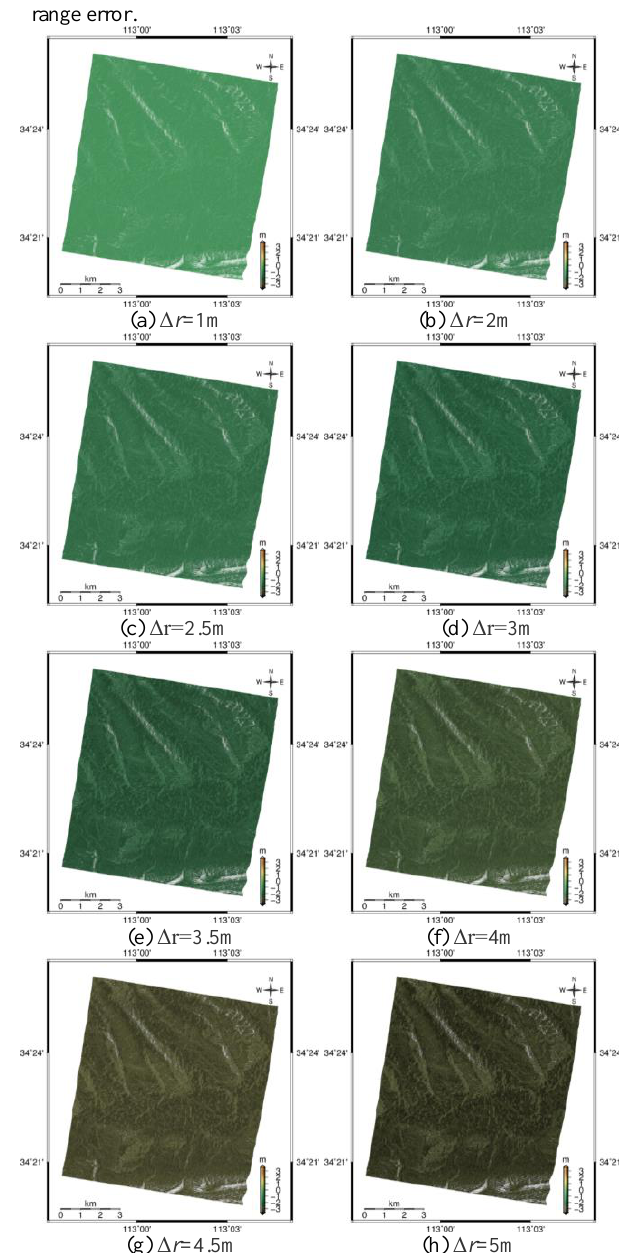
Figure 8. Height error distribution graph induced by different slant range error The simulation results indicate that the slant range error has obvious influence on the InSAR height measurement. With the increase of slant range error, the height measurement error raises gradually, which show good agreement with the theoretical